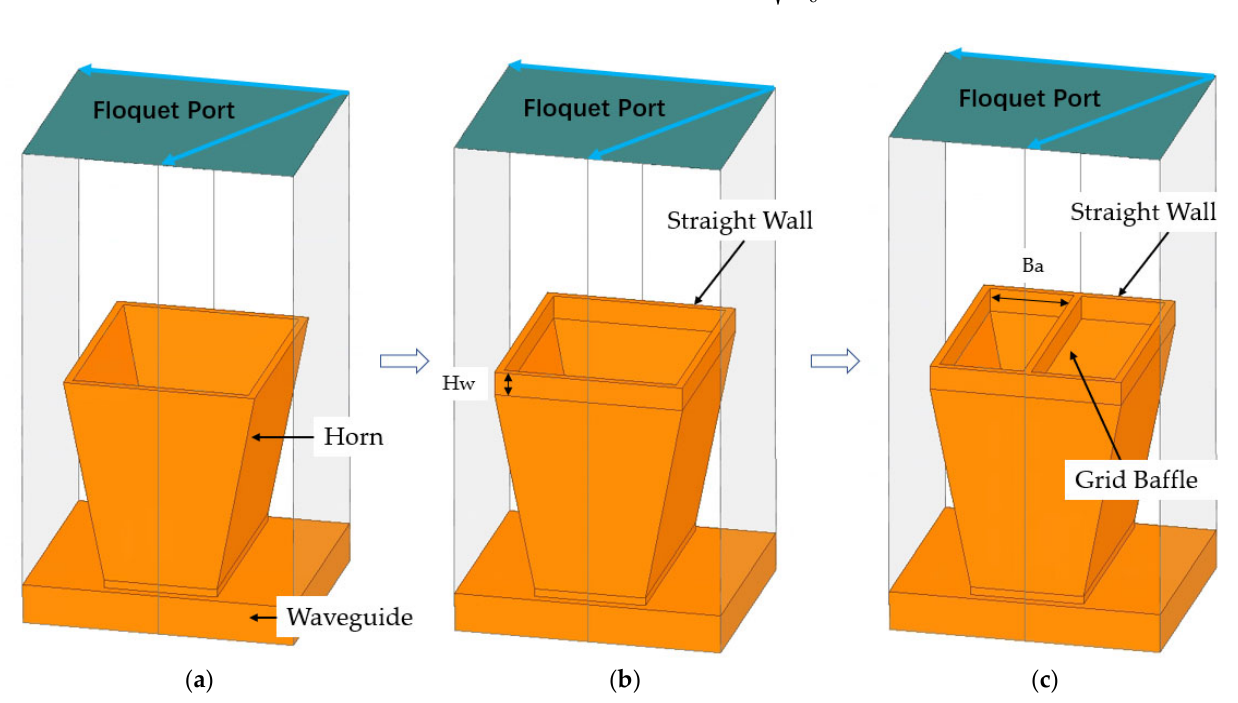
Figure 2. Design evolution of the HPM antenna unit consisting of a horn and a waveguide: ( a ) the basic antenna unit, ( b ) adding a straight wall to the horn radiator, and ( c ) adding a grid baffle at the center of the straight wall.